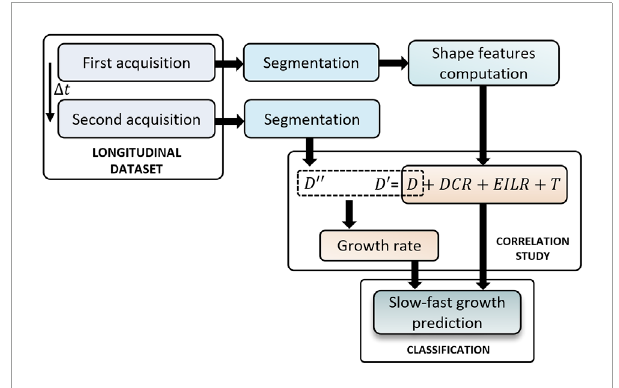
FIGURE 1 Full workflow for identifying patients at high risk of aneurysm growth.